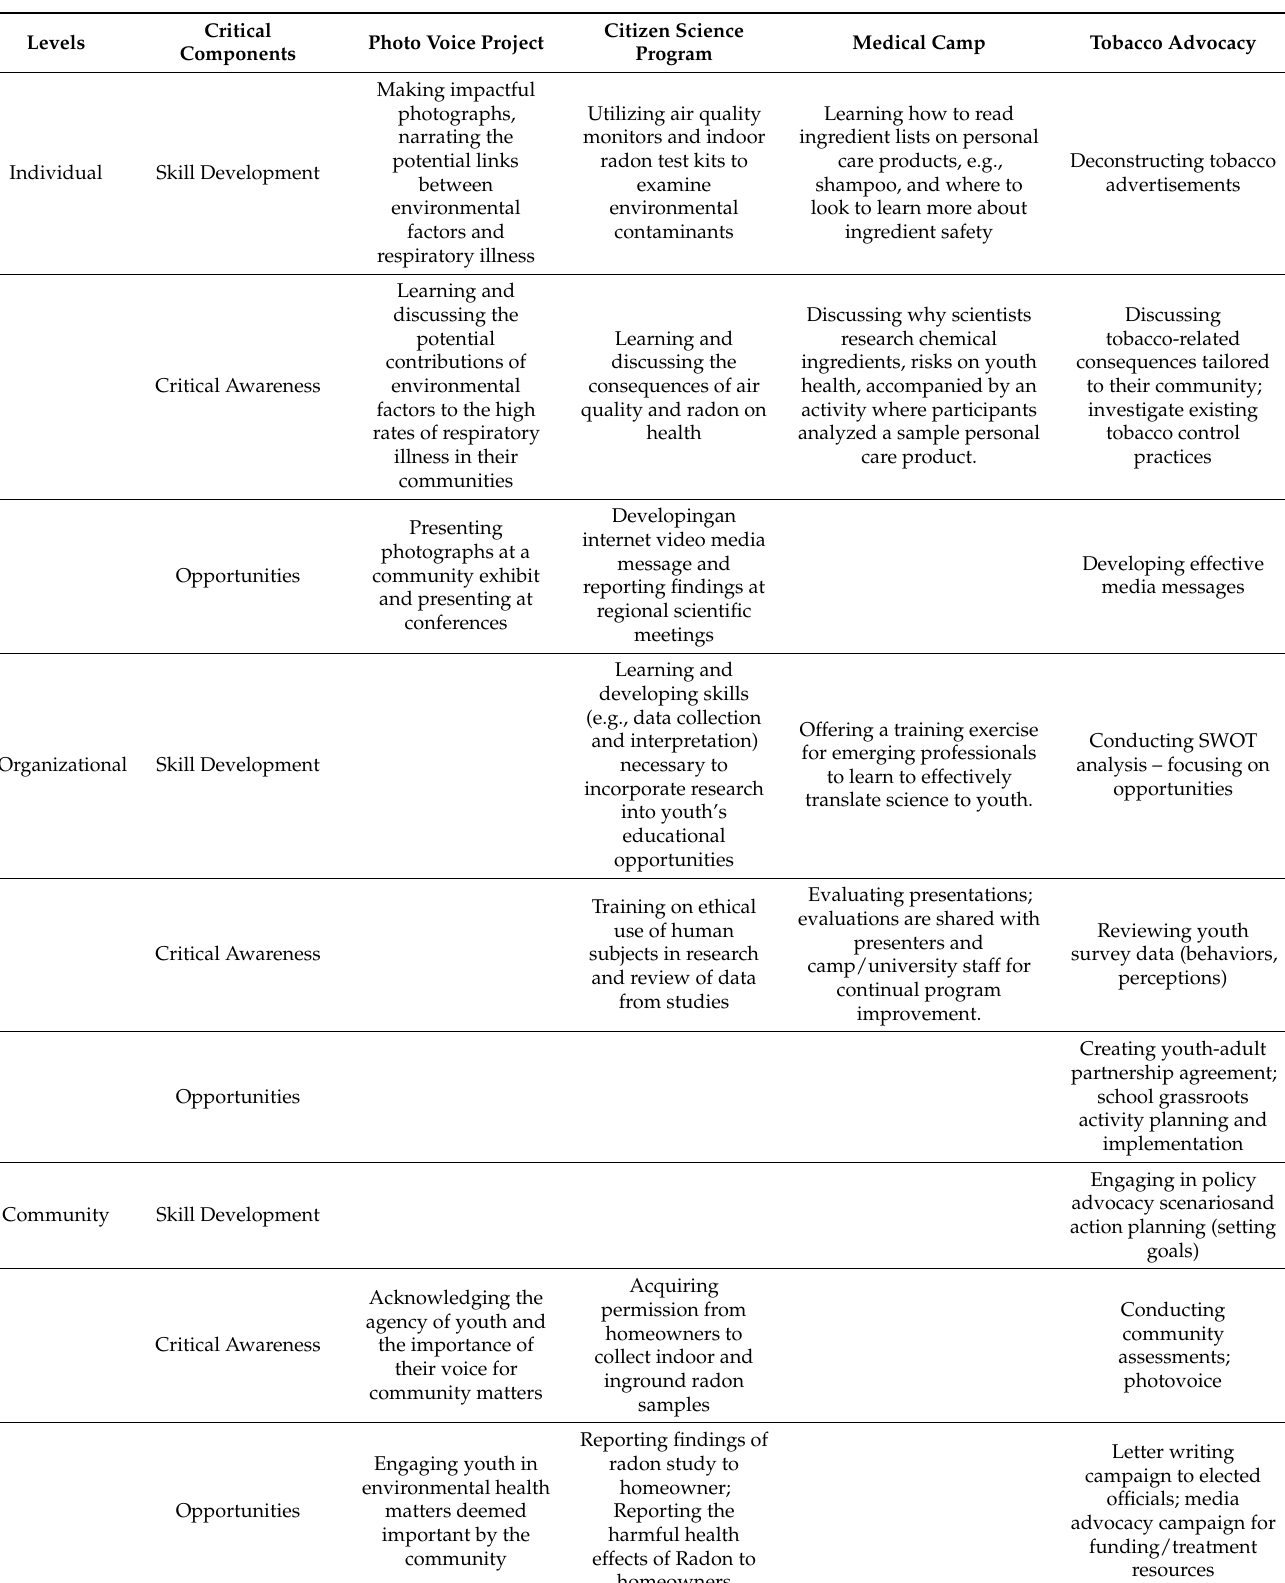
Table 2. Application of the Youth Empowerment Model across Four Case Studies: Critical Components by Empower- ment